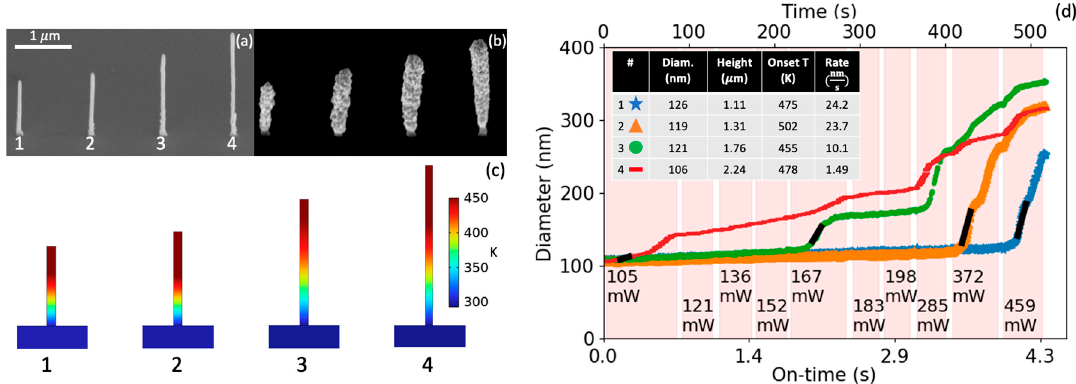
Figure 2. SEM images of the ( a ) as-deposited AuC x nanopillars and ( b ) after the cumulative gold deposition realized during the laser power study. ( c ) Results from finite element modeling of the temperature profile at the end of the laser pulse width for the various nanopillars at the associated laser onset powers. ( d ) Plot of nanopillar diameter versus laser on-time (bottom x -axis) and processing time (top x -axis) with increasing laser power noted; the highlighted red regions correspond to the labeled laser powers. The inset table in ( d ) shows the nanopillar diameter, height, modeled onset temperature, and onset growth rate at the beginning of deposition.